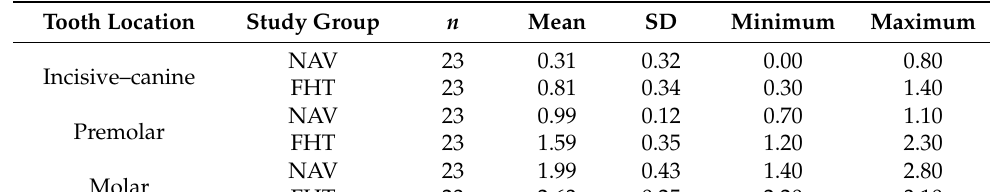
Figure 7. Box plot of the apical deviations in planned and performed orthodontic micro-screws between computer-aided static navigation technique and conventional freehand technique study groups. Table 4. Descriptive deviation values at apical end-point (mm) of the orthodontic micro-screws placed by using conventional freehand technique and computer-aided static navigation technique study groups in the incisive–canine, premolar and molar dental sector.